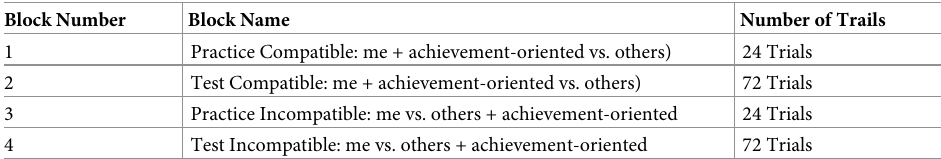
Table 2. Overview of blocks presented in the perfectionism single category